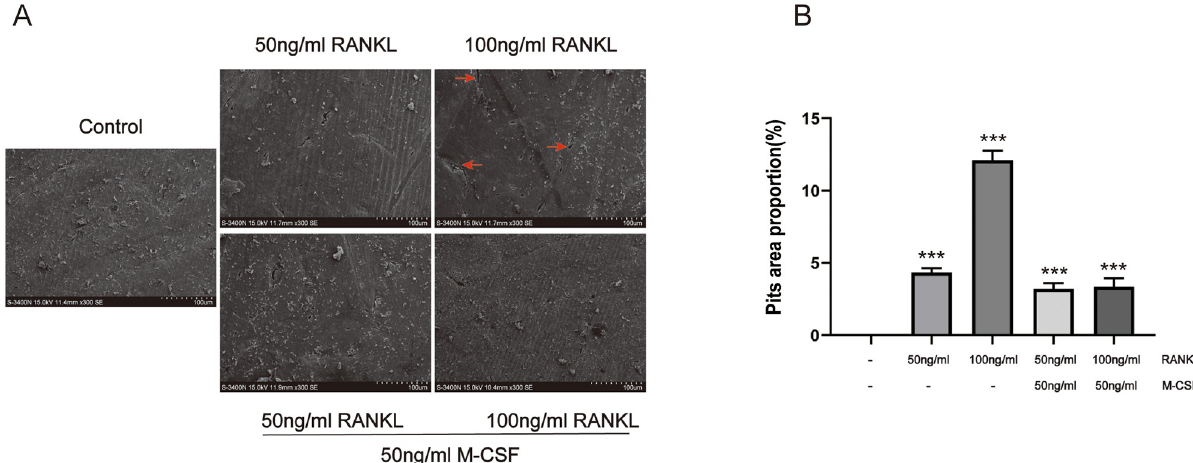
Fig 3. Effects of different induction conditions on bone resorption pits. RAW264.7 cells were plated on bovine bone slides with different concentrations of RANKL with or without M-CSF for 7 days. (A) Bone resorption pits were detected by SEM on day 7, original magnification of × 300 (Scale bar = 100 μ m), red arrow indicates bone resorption pits. (B) Quantitative analysis of bone resorption pit area. Data are presented as mean ± SD (n = 3). Statistically significant ( ��� P < 0.001).